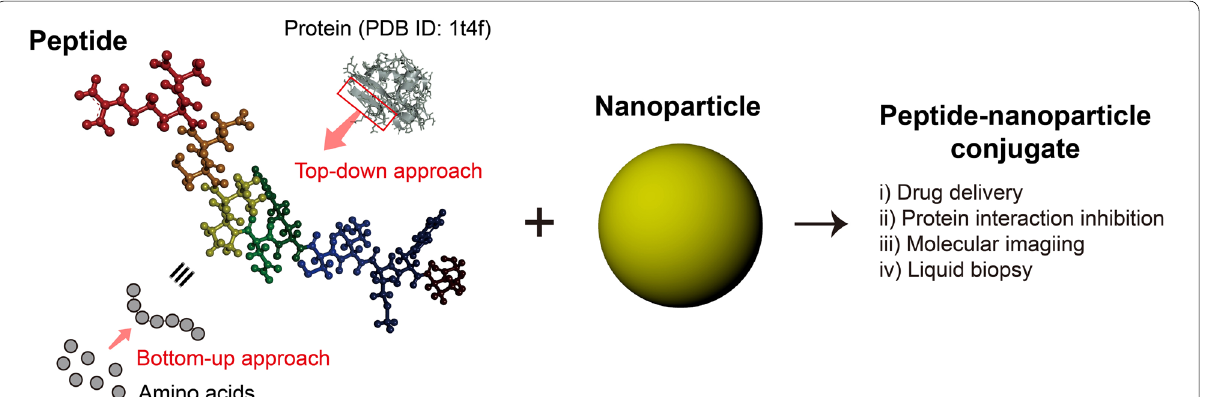
Fig. 1 Discovery of artificial bioactive peptides and their conjugation with nanoparticles for biomedical